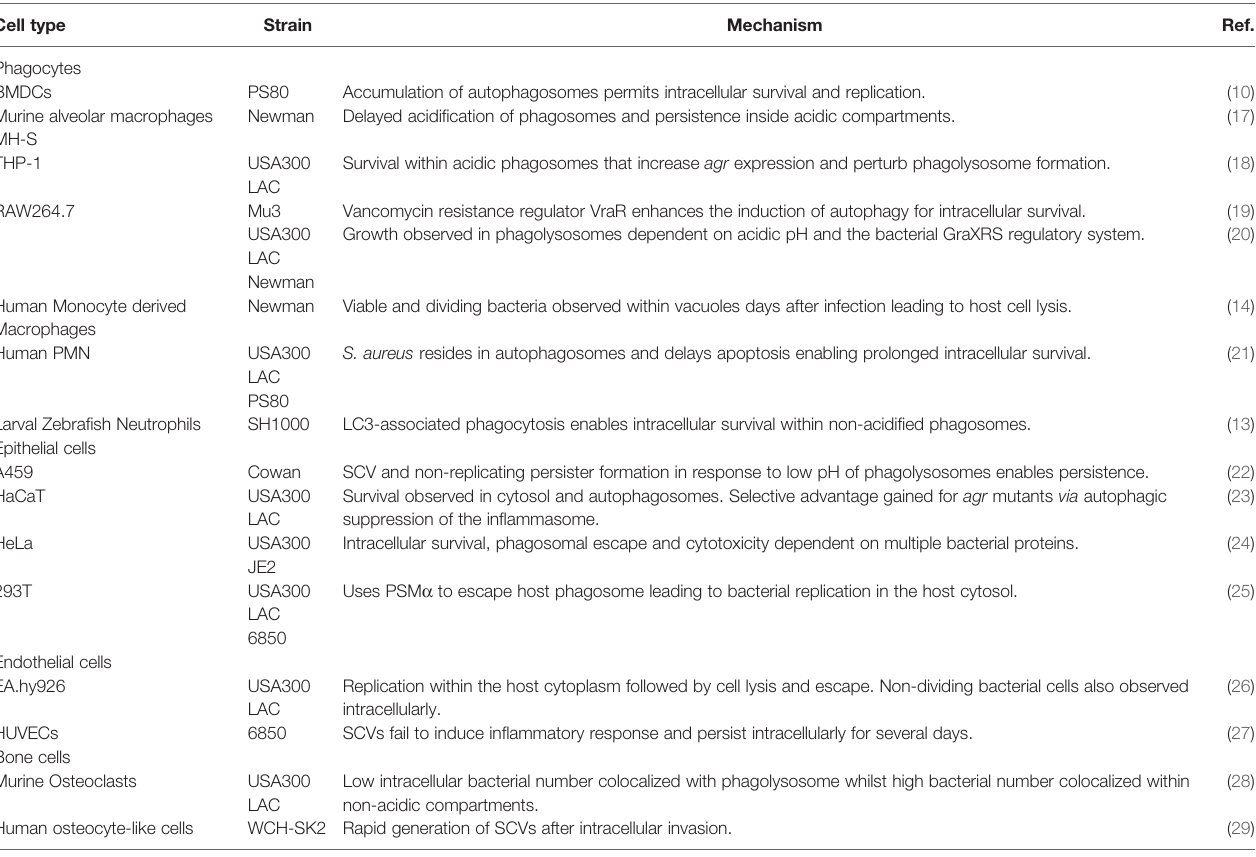
TABLE 1 | Intracellular survival of S. aureus has been shown across a range of cell types and involving multiple mechanisms. Cell type